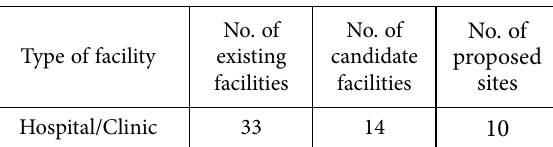
Table 3. Details of the different